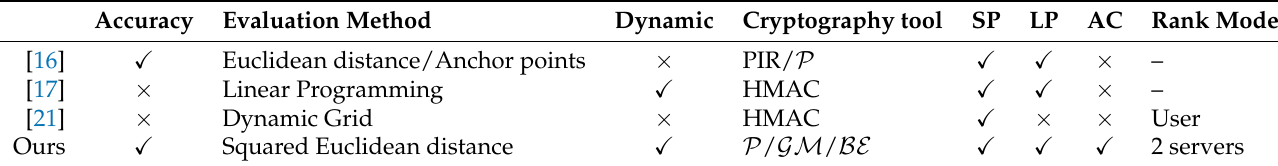
Table 2. Properties